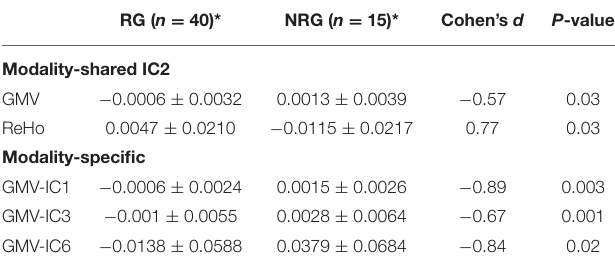
TABLE 4 | Discriminative ICs between the RG and